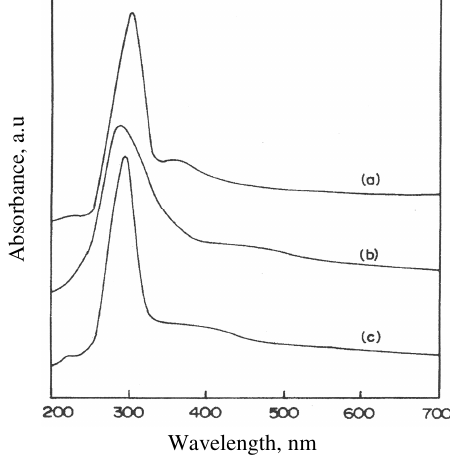
Figure 1. UV-visible spectra of aniline (a), o -toluidine (b) and o -anisidine (c) intercalated clay The anilinium ion peak was disappeared after mechanochemical polymerization of aniline-MMT in presence of stoichiometric quantity of oxidizing agent, (NH new peaks were observed for the polyaniline/clay nanocomposite, one at 30 nm and another at 650 nm and were assigned as π - π * and localized polaron- π transition. Due to the confined arrangement of polymer within the clay lattices, the polaron band is slightly blue